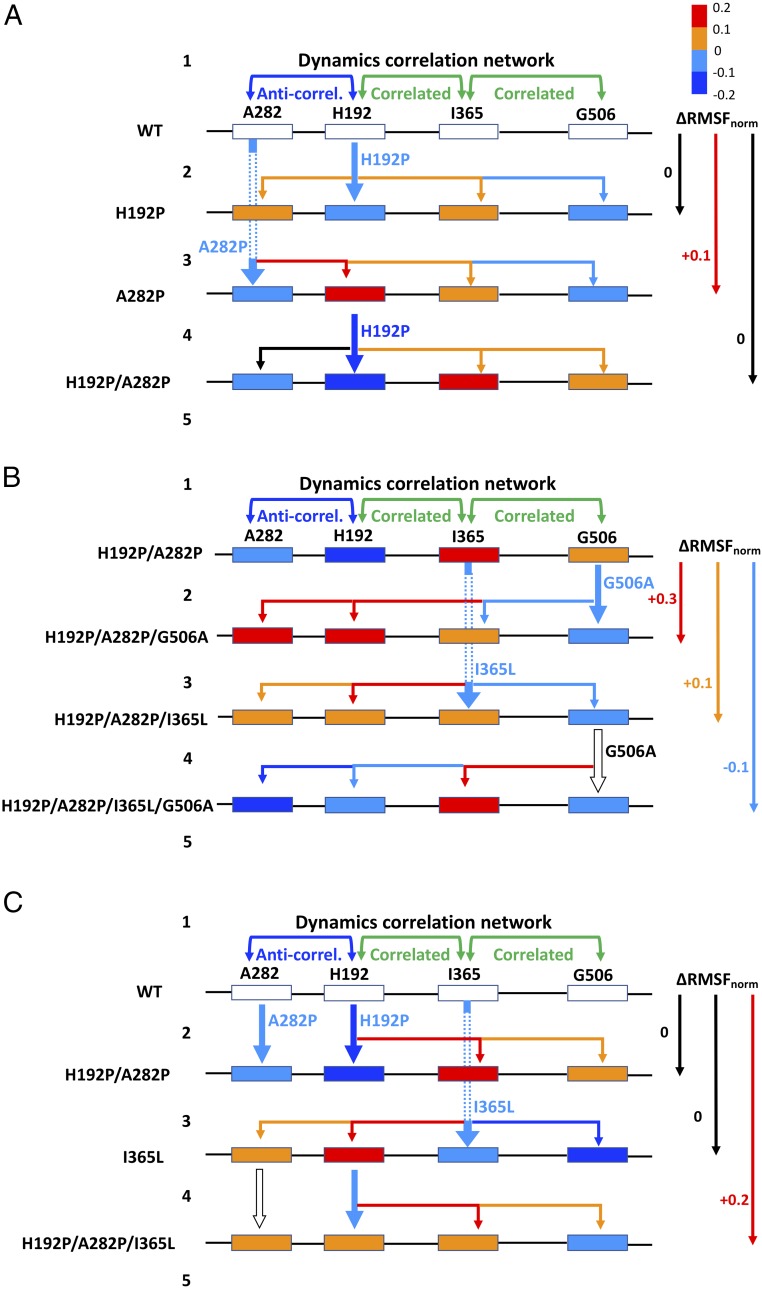
Correlated dynamics link flexibility changes around the four mutations and mediate epistasis between them. Box colors indicate ∆RMSFnorm relative to WT at each mutation site, averaged from 11 sequential residues centered on the mutation site. Thick arrows denote mutations. Thin arrows denote impacts on other sites via correlated dynamics. Arrows are colored by ∆RMSFnorm upon mutation. A–C represent single pairwise interactions, with the cause of their epistasis explained in steps 1–5 starting with a common step 1: 1, dynamics correlation network links flexibility of four mutational sites, then (A) H192P and A282P. 2, H192P is locally stabilizing. Correlated dynamics destabilizes A282 and I365, and stabilizes G506. 3, A282P is locally stabilizing. Correlated dynamics destabilizes H192 and I365, and stabilizes G506. 4, H192P is locally stabilizing. Correlated dynamics destabilizes at I365 and G506. 5, Negative epistasis in ∆RMSF between H192P and A282P; (B) I365L and G506A, within H192P/A282P. 2, G506A is locally stabilizing. Correlated dynamics stabilizes I365 and destabilizes H192P/A282P. 3, I365L is locally stabilizing. Correlated dynamics stabilizes G506 and destabilizes H192P/A282P. 4, G506A now has no impact. Correlated dynamics destabilizes I365L and stabilizes H192P/A282P. 5, Reciprocal sign epistasis in ∆RMSF between G506A and I365L; (C) I365L and H192P/A282P. 2, H192P/A282P are locally stabilizing. Correlated dynamics destabilizes I365 and G506. 3, I365L is locally stabilizing. Correlated dynamics stabilizes G506 and destabilizes H192P/A282P. 4, H192P is locally stabilizing. Correlated dynamics destabilizes I365L and G506. 5, Positive epistasis (destabilizing direction) in ∆RMSF between H192P/A282P and I365L.